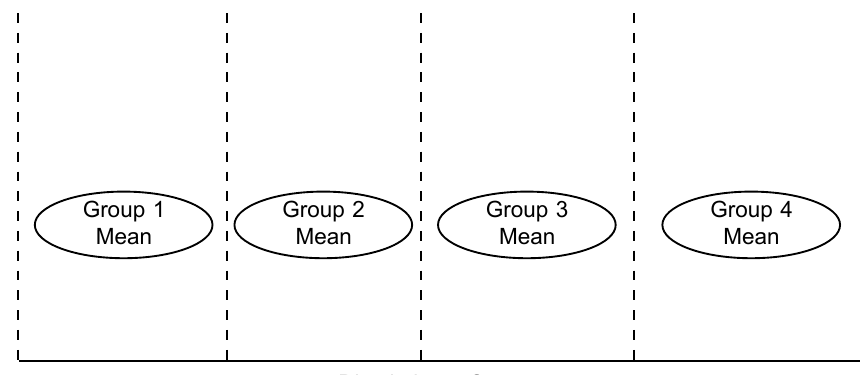
Figure 3. Interval partitioning of discriminant space of four groups with